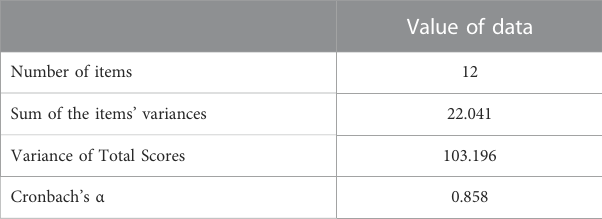
TABLE 3 The Reliability analysis of Questionnaire B results.